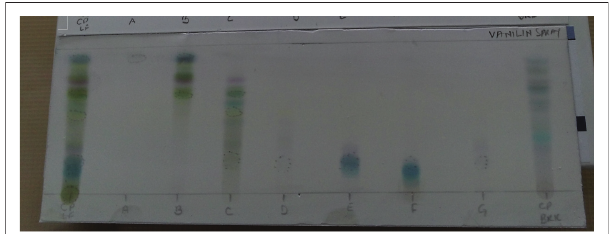
FIGURE 3: Comparison of chemical components present in leaves of C. anisata (Fractions A–G). Thin-layer chromatography plates were developed in hexane: EtOAC (2:1) and sprayed with vanillin only.